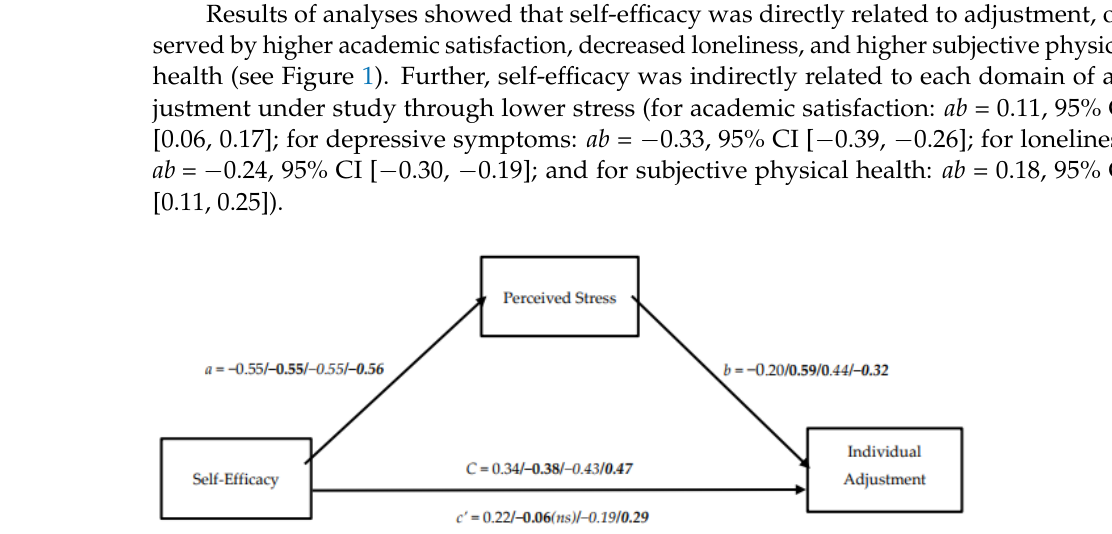
Figure 1. Results of the Mediator Model Testing among self-efficacy, perceived stress, and individual adjustment. Note: Four unstandardized coefficients are listed to show results for four adjustment indicators. The first is for academic satisfaction, the second (in bold) is for depressive symptoms, the third (in italics) is for loneliness, and the fourth (in italics and bold) is for subjective physical health. C = total effect of independent variable (IV) on dependent variable (DV); a = IV to mediator; b = direct effect of mediator on DV; c’ = direct effect of IV on DV. All p < 0.001, unless noted